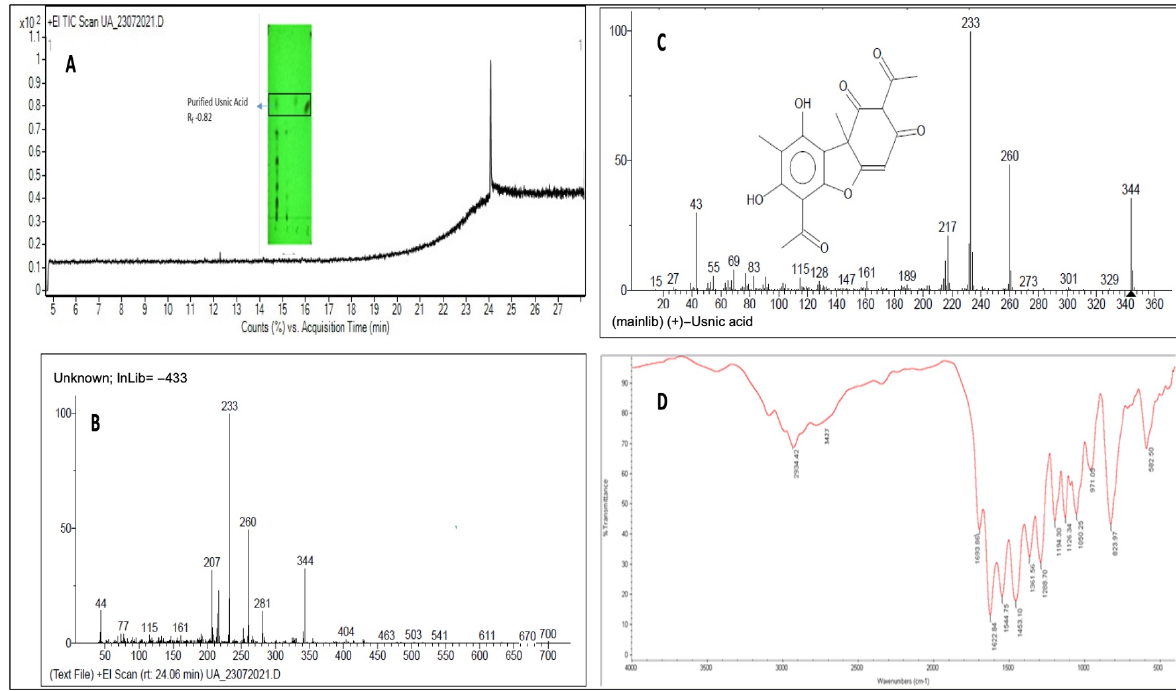
Figure 3. Purification and characterization of usnic acid from Usnea cornuta acetone extract (UC2A). ( A ) Inset: TLC analysis of UC2A and the purified compound, usnic acid, with R f = 0.82. Full TIC scan of purified compound, usnic acid, via GCMS at a retention time of 24.06 min. ( B ) +EI scan of peak at 24.06 min of usnic acid in UC2A and ( C ) usnic acid in the NIST database; both fragmentation patterns matched, indicating that the TLC-eluted compound was usnic acid. ( D ) FTIR spectrum of usnic acid from UC2A indicating the presence of functional groups.